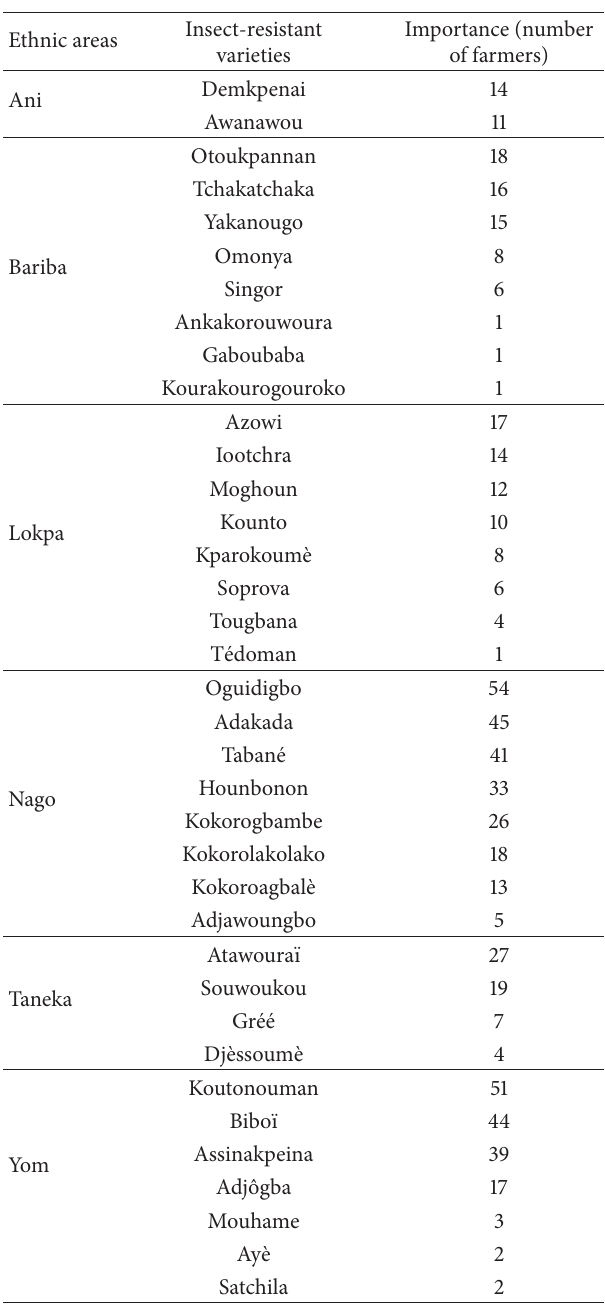
Table 7: Kokoro yam cultivars tolerant to storage insect pests and their importance across ethnic